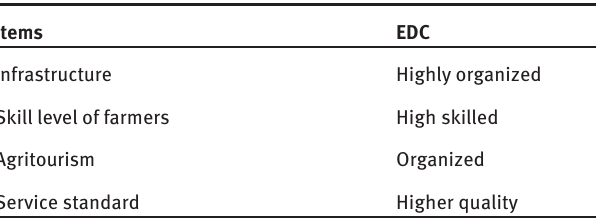
Table 1: Differences between EDC and EDN